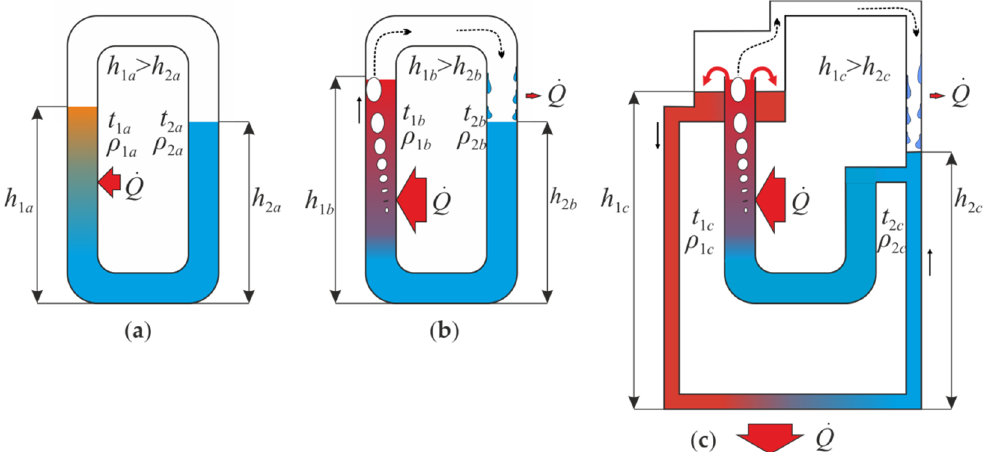
Figure 5. The operating principle of a reverse thermosiphon with one working medium: ( a ) difference in the height of the liquid column in heat pipes resulting from differences in temperature; ( b ) boiling liquid increases the difference in the height of the liquid column in heat pipes; ( c ) circulation in a reverse thermosiphon with one working medium; h 1a , h 2a , h 1b , h 2b , h 1c , h 2c – height of the liquid column in heat pipes; t 1a , t 2a , t 1b , t 2b , t 1c , t 2c , – liquid temperature; ρ 1a , ρ 2a , ρ 1b , ρ 2b , ρ 1c , ρ 2c , – liquid density.